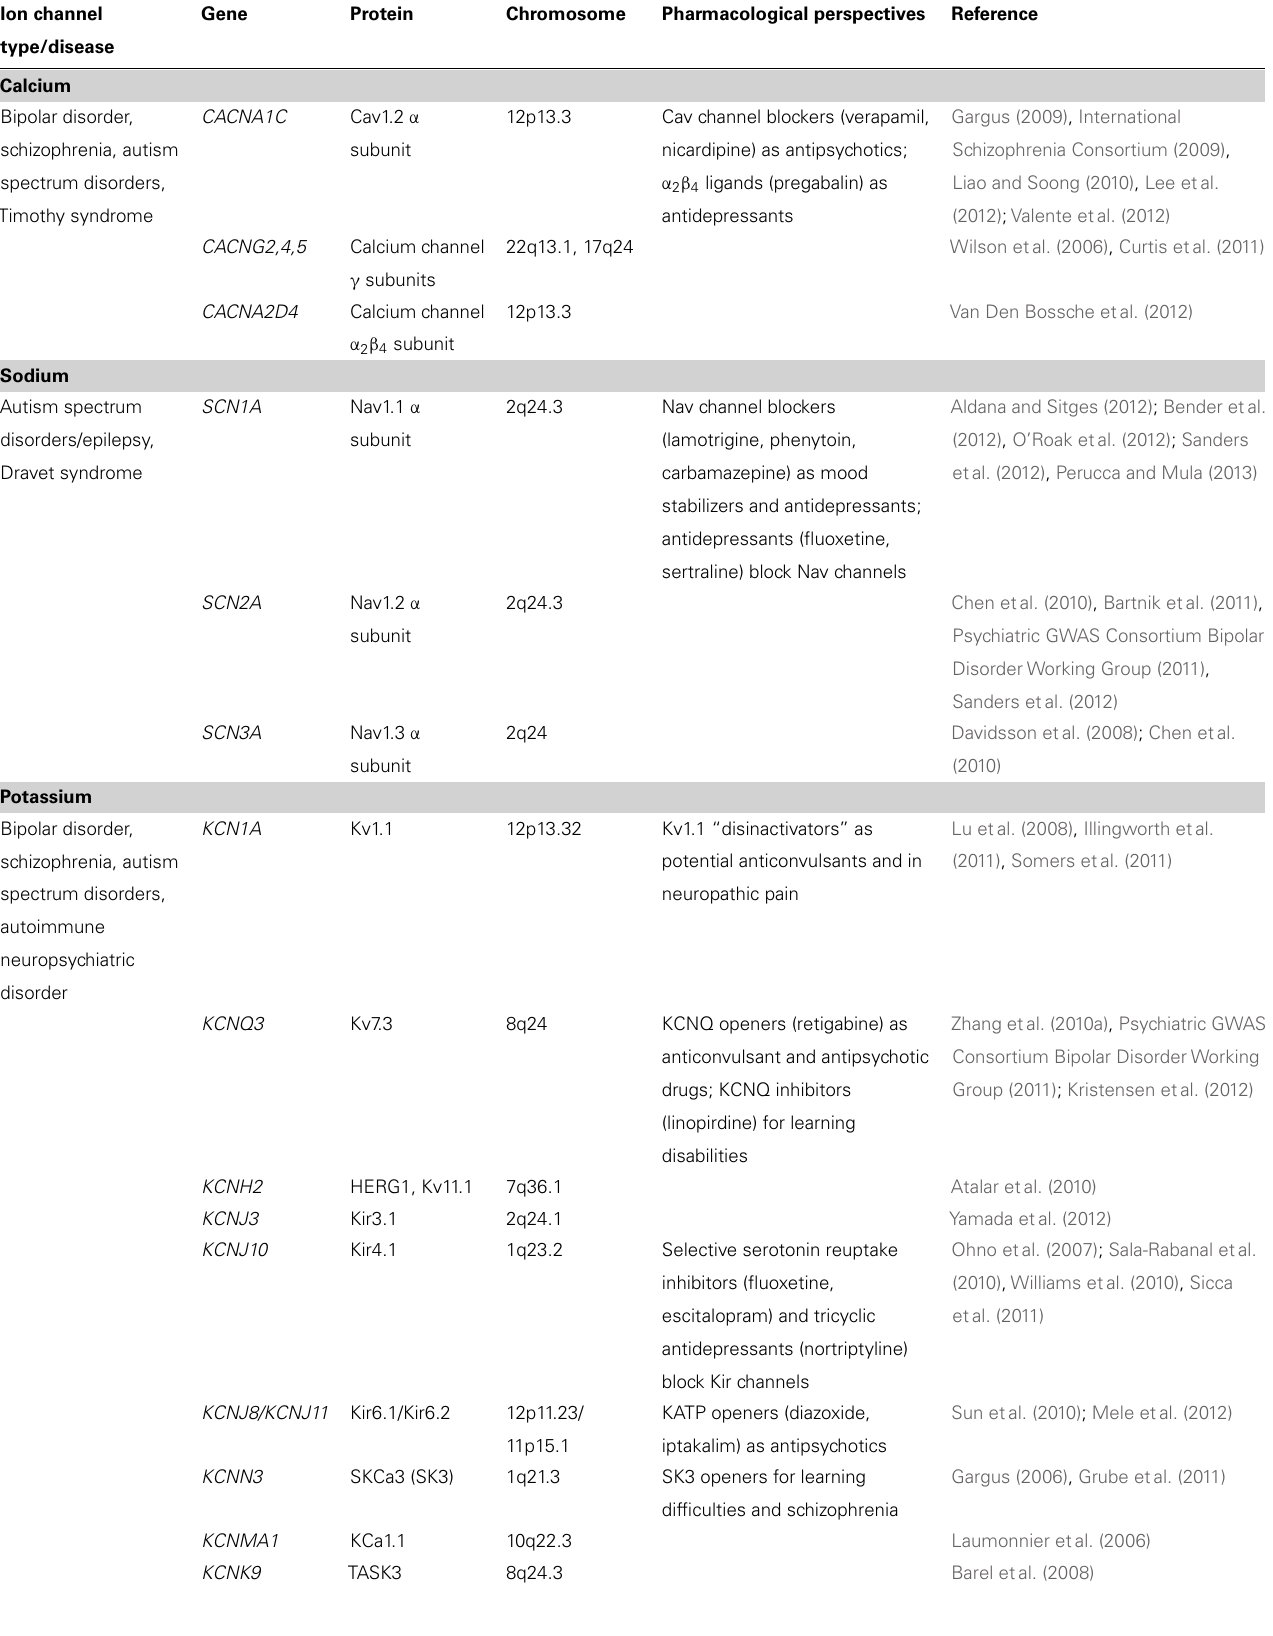
Table 1 | Ion channels involved in main neuropsychiatric